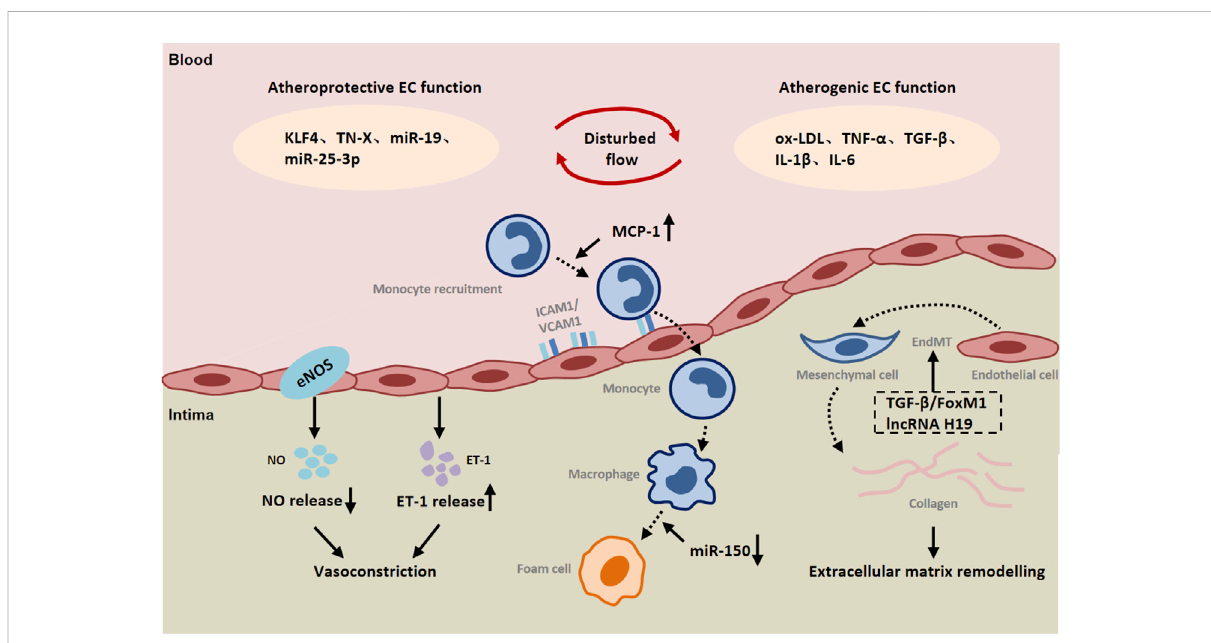
The role of endothelial cells (ECs) in peripheral arterial disease (PAD). Both atheroprotective and atherogenic mechanisms are operative in endothelial cells (ECs) exposed to disturbed fl ow. Endothelial cells are involved in communication with immune cells and smooth muscle cells by releasing a variety of in fl ammatory cytokines, chemokines and ET-1. Endothelial-to-mesenchymal transition (EndMT) contributes to vascular remodeling. Abbreviations: KLF4, Kruppel like factor 4; TN-X, Tenascin-X; oxLDL, oxidized low-density lipoprotein; IL-1 β , interleukin 1 β ; IL-6, interleukin 6; TGF- β , transforming growth factor- β ; ICAM-1, intercellular cell adhesion molecule-1; VCAM-1, vascular cell adhesion molecule-1; MCP-1, monocyte chemotactic protein-1; FoxM1, Forkhead Box M1; ET-1,